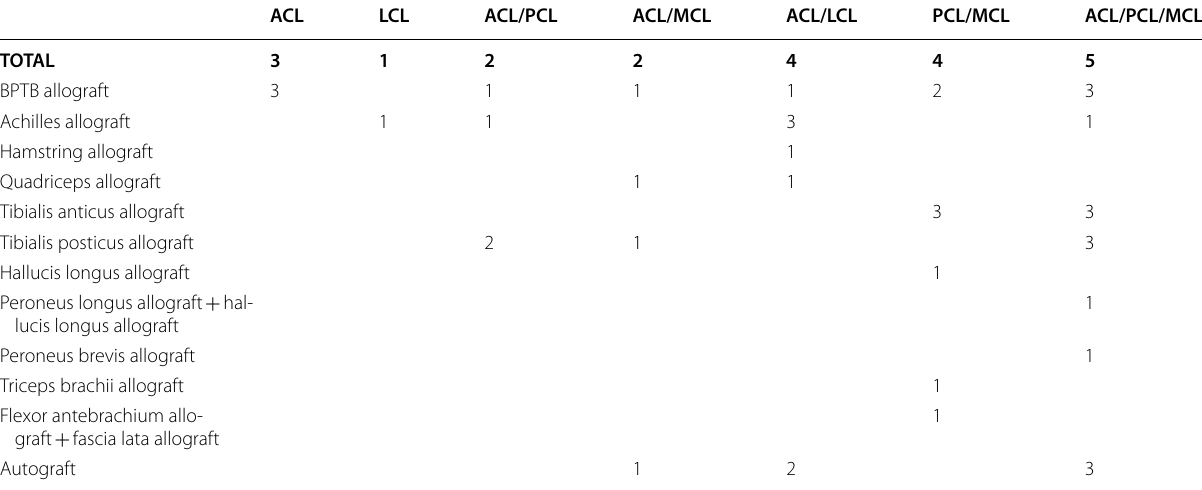
Table 2 The various combinations of ligament reconstructions and grafts used ACL